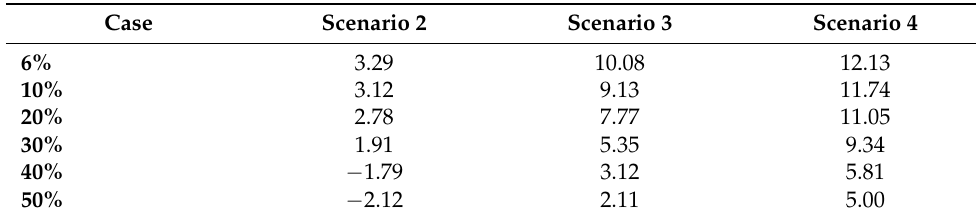
Table 4. Damping performance of interarea mode with high RESs. Table 5. Damping performance of local mode 2 with high